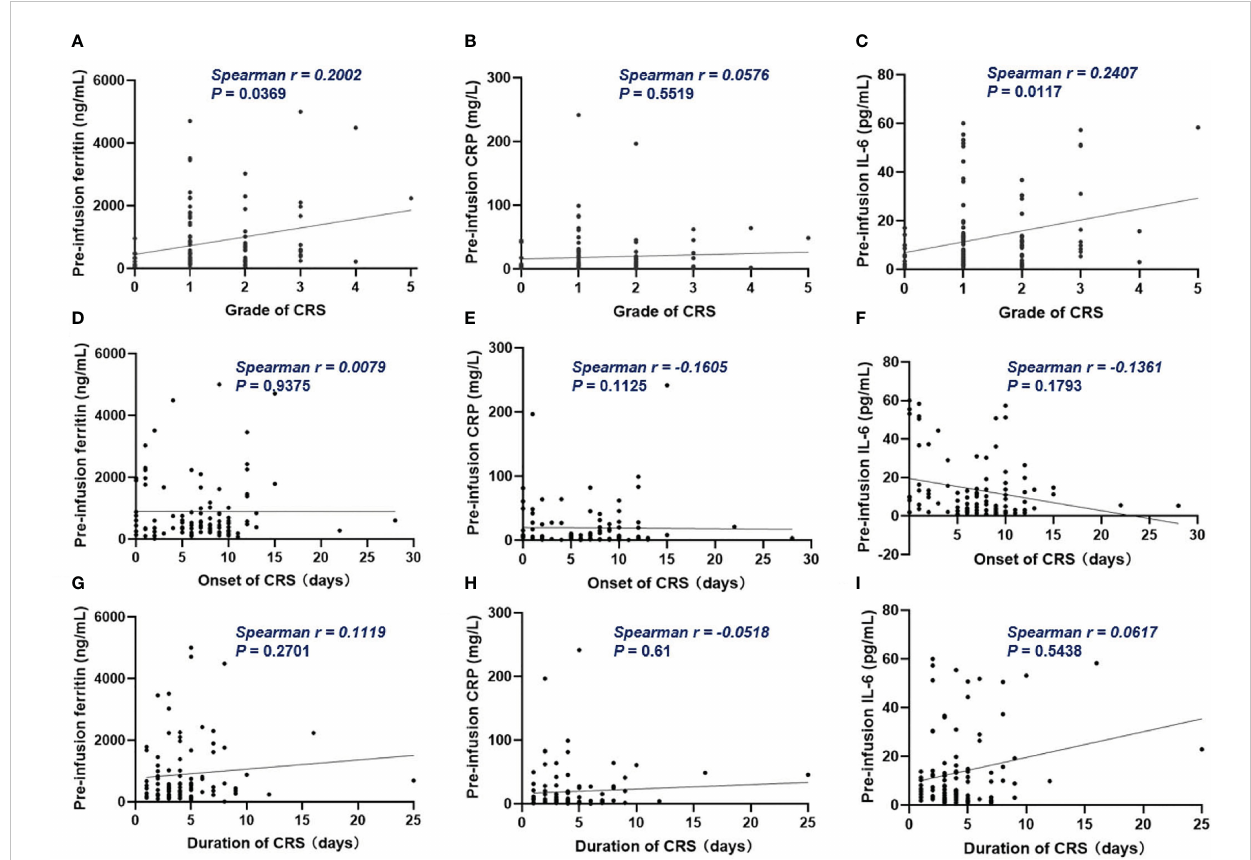
FIGURE 4 The correlation between in fl ammatory markers and CRS. (A, C) Pre-infusion ferritin and IL-6 correlated with the grade of CRS. (B) Pre-infusion CRP had no correlation with the grade of CRS. (D – I) The pre-infusion ferritin, CRP and IL-6 had no correlation with the onset and the duration of CRS. Spearman r value was calculated using the Spearman ’ s correlation